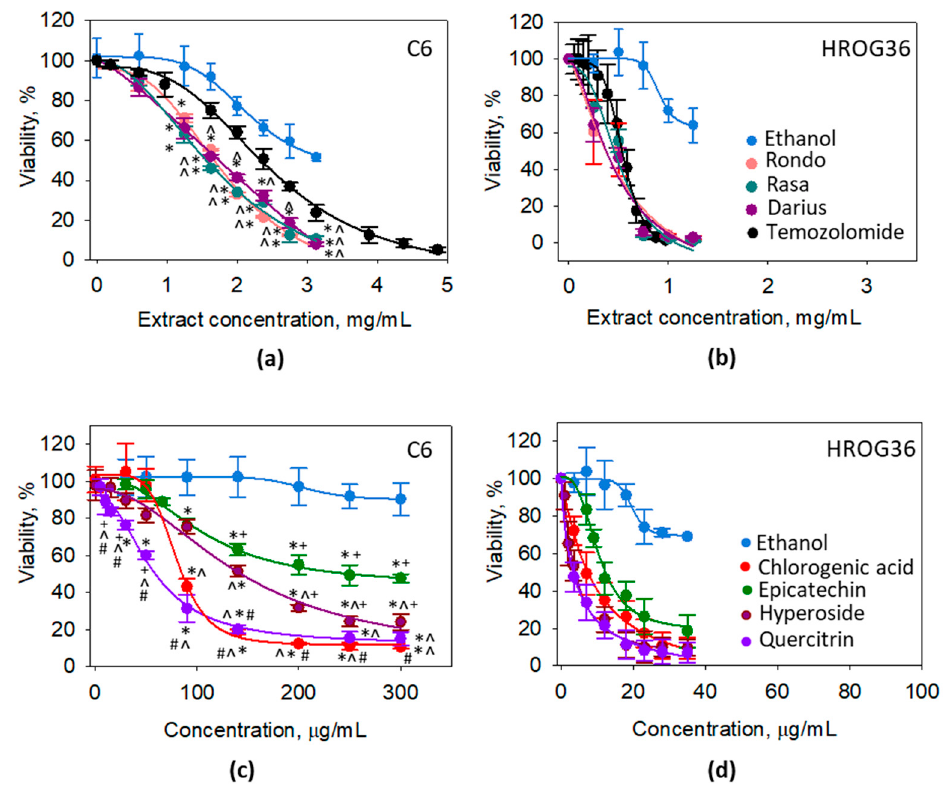
Figure 1. The effect of the extracts from leaves of different Japanese quince cultivars ( a , b ) and some phenolic compounds found in the extracts ( c , d ) on viability of glioblastoma C6 ( a , c ) and HROG36 ( b , d ) cells evaluated by metabolic activity assay with PrestoBlue reagent. For Ethanol, the concentrations were the same as in other samples at the indicated concentration point, i.e., 35, 50, 65, 80, 95, 110, 125, and 150 L/mL. In both ( a , c ), * indicates significant difference compared with ethanol-only treated samples; in ( a ), ˆ significant difference compared with temozolomide; in ( c ), ˆ significant difference compared with Epicatechin, + with Chlorogenic acid, # with Hyperoside. In ( b ), all extract-treated samples were statistically significantly different from Ethanol starting from concentration 0.25 mg/mL, and Temozolomide–starting from 0.5 mg/mL. in ( d ), all the samples were statistically significantly different from Ethanol starting from the concentration of 7 g/mL, and there was statistically significant difference between Epicatechin and other samples at 7 and 9 g/mL. The level of significance p < 0.05.